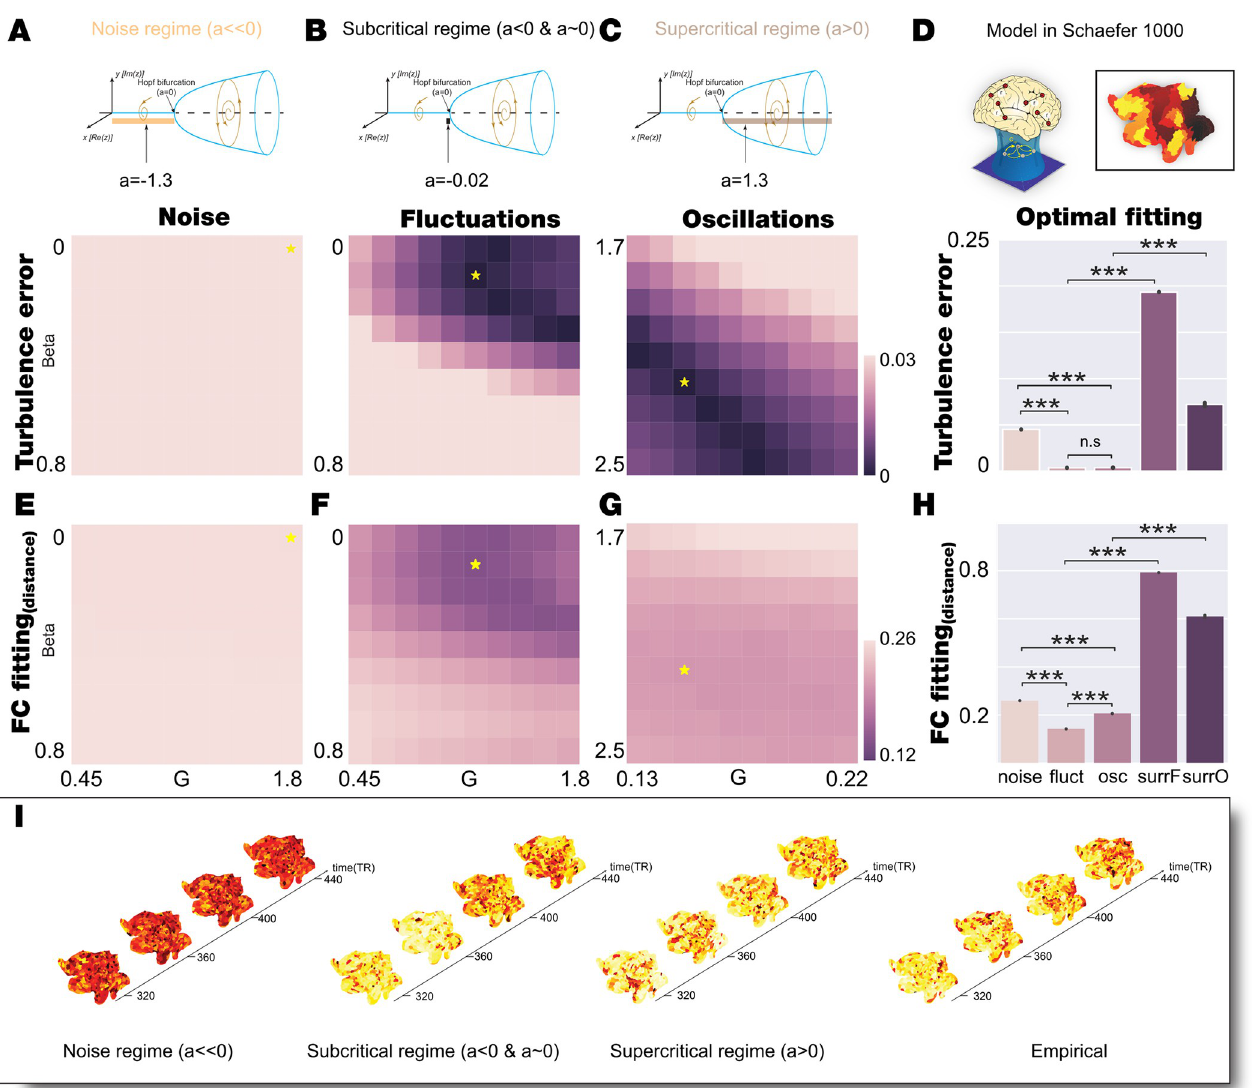
Fig 2. Model Schaefer1000 fitting of noise, fluctuations, and oscillatory for 1) Turbulence and 2) FC. A-C) We explored the bi-dimensional parameter space defined by β and G for noise, fluctuating and oscillatory regime (bifurcation parameter a = -1.3, a = -0.02 and a = 1.3, respectively, indicated in upper row). We computed the level of amplitude turbulence error as the absolute difference between the empirical and simulated turbulence. Yellow stars indicate the ( β , G) combination that reaches the lowest turbulence error in each regime. D) The upper subpanel shows the model fitting scheme in fine Schaefer1000 parcellation (the render on a flatmap of the hemisphere stands for a scheme of brain regions considered in this parcellation). The bottom subpanel displays the barplot that indicates the statistical distribution of the level of amplitude turbulence obtained by simulating 20 trials with 100 subjects for each model regime with the parameters set at the corresponding working point. We also display the results of two model-based surrogates created by increasing the shear parameter of each model regime. The red dashed line indicates the empirical level of amplitude turbulence averaged across participants. The subcritical, supercritical and empirical level of turbulence are not statistically different (Wilcoxon test, P = 0.33), the rest of the comparison are statistically significant (Wilcoxon test, P < 0.001). E-G) We explored the bi-dimensional parameter space defined by β and G for noise, fluctuating and oscillatory regime computed the FC fitting as Euclidean distance between the empirical and simulated FC. Yellow stars indicate the ( β , G) combination that reaches the lower turbulence error in each regime (the optimal working point obtained in panels A-C). H) The barplot indicates the statistical distribution of the FC fitting obtained by simulating 20 trials with 100 subjects for each model regime at the corresponding working point defined as the minimum turbulence error. We also display the results for the model-based surrogates. All comparisons are statistically significant (Wilcoxon, P < 0.001). I) Visualization of the change of the local Kuramoto order parameter, R, in space and time reflecting amplitude turbulence in a single simulation at the optimal working point of each regime (noise, fluctuating and oscillatory cases) and one participant (empirical). This can be appreciated from continuous snapshots for segments separated in time rendered on a flatmap of the